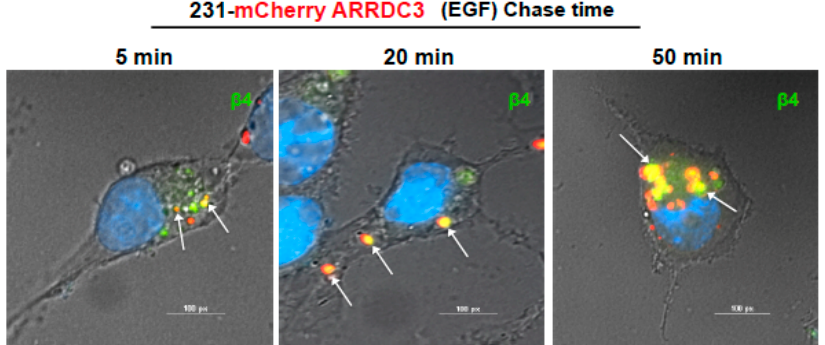
Figure 1. ARRDC3 inhibits EGF-driven endocytic recycling of ITG β 4 in triple negative breast cancer (TNBC) cells. ( A ) MDA-MB-231 cells were serum starved for 24 h and then stimulated with EGF (20 ng/ µ L) for the indicated time. Cells were stained with fluorescence tagged antibodies against ITG β 4 (green) or Rab5 (Red) and DAPI (for nucleus). Arrows indicate ITG β 4 inside Rab5-labled early endosomes. Scale bar: 50 µ m. ( B ) Biotin-based recycling assay of ITG β 4 was performed in MDA-MB-231 cells with or without ARRDC3 expression as described in materials and methods section. At each chase time with EGF stimulation, cells were lysed to release biotinylated proteins. Biotinylated ITG β 4 were detected by immunoprecipitation (IP). Input: whole cell lysate. Representative blots of 3 independent experiments are displayed with relative input protein (Biotinylated- β 4/ β 4 in arbitrary unit. ( C ) MDA-MB-231 cells were transfected with or without mCherry-ARRDC3 plasmid. Immunofluorescence-based ITG β 4 recycling assay were performed as described in materials and methods. Immunofluorescence signals were captured by fluorescence microscope with DIC (differential interference contrast) optic (green; ITG β 4, red; ARRDC3, yellow; co-localization). Scale bar: 100 µ m. Representative images were selected from three independent experiments.